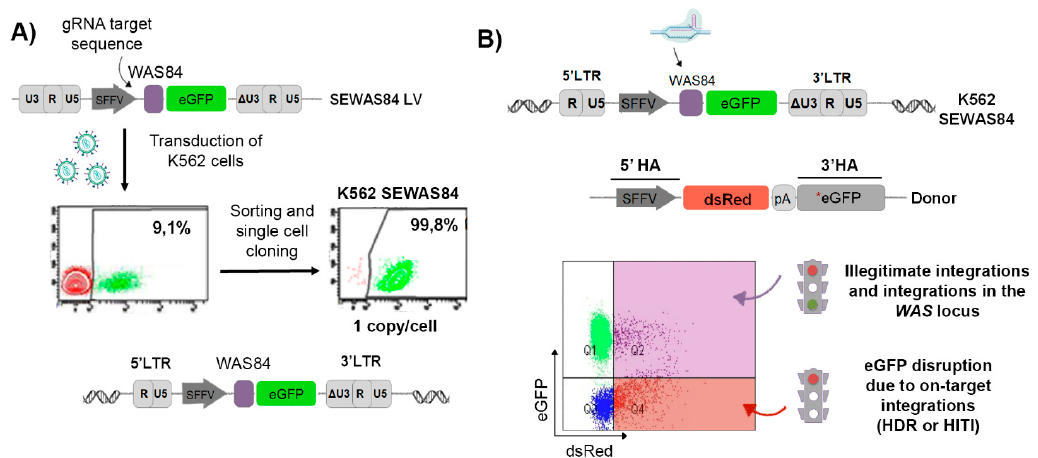
Figure 1. Development of K562 SEWAS84 reporter cell line (eGFP-OFF / dsRED-ON). ( A ) Generation of the K562 SEWAS84 reporter cell line. Top: Representative scheme of the SEWAS84 lentiviral plasmid. Left: Representative plots of K562 cells transduced with SEWAS84 LVs at MOI = 0.1. The eGFP + population was sorted to generate the K562 SEWAS84 cell line expressing eGFP and containing 1 copy was obtained by single-cell cloning. ( B ) Scheme of the strategy for targeting the WAS sequences to